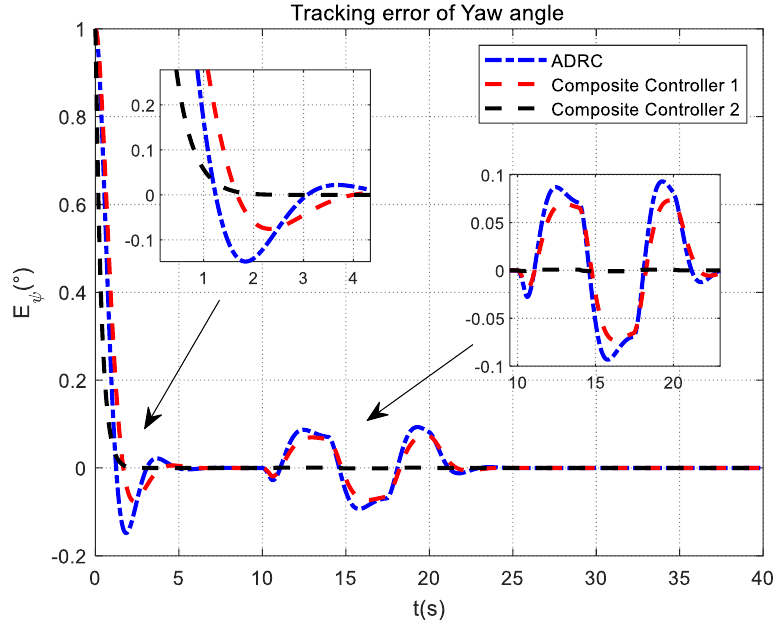
Figure 15. Tracking error of Yaw angle control for QUAV under actuator constant fault and disturbance condition.